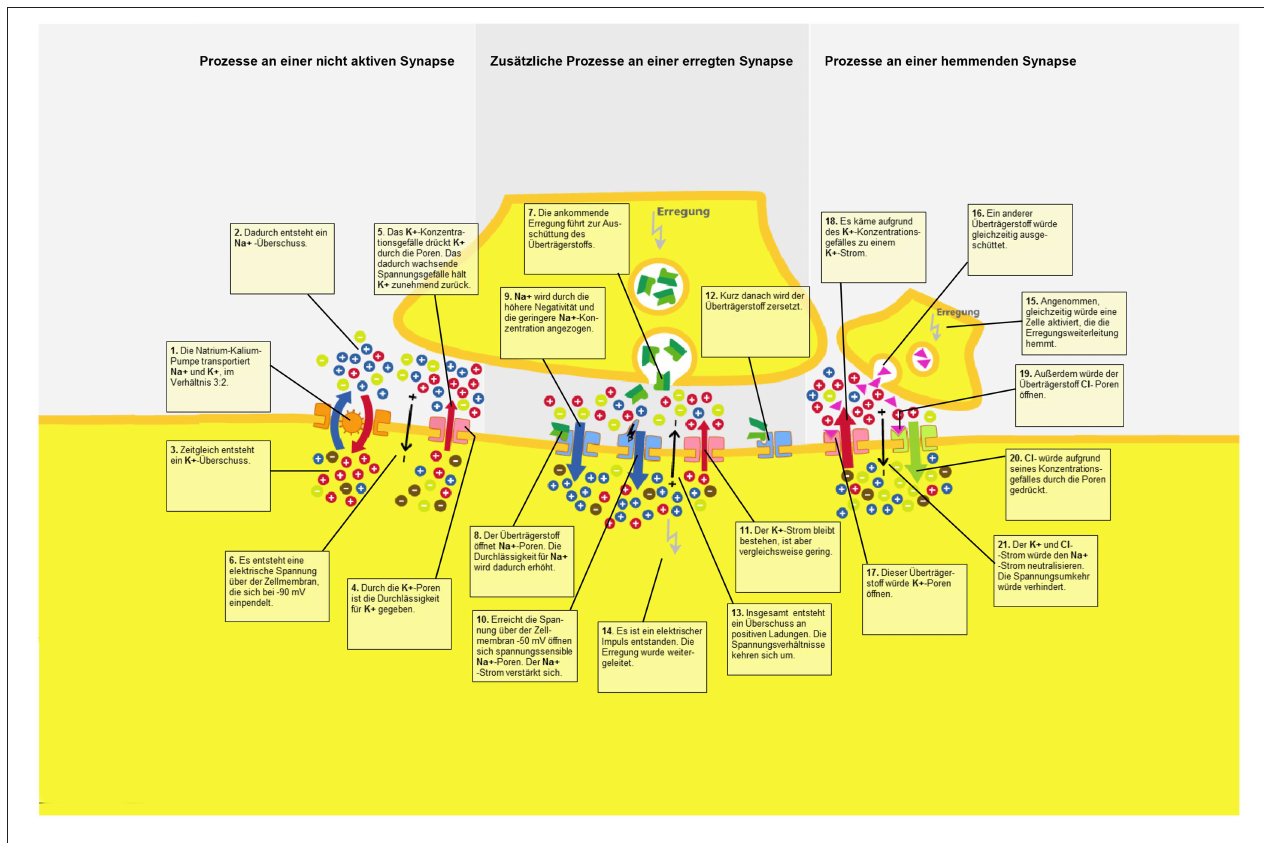
FIGURE 4 | Integrated text-picture presentation with medium spatial proximity in Experiment